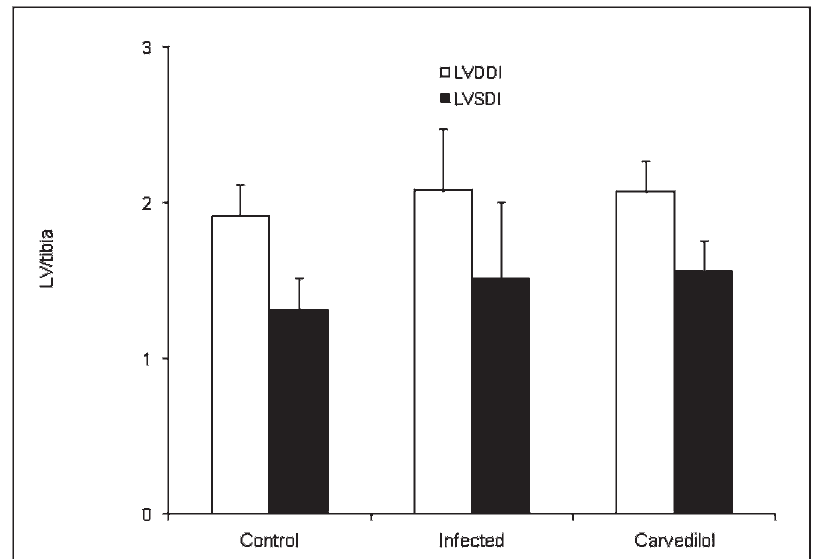
Figure 2 - Neither the left ventricular diastolic diameter index nor the left ventricular systolic index differed between groups at 11 months ( p =0.238 and p =0.06, respectively).